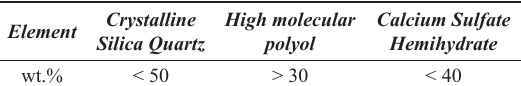
Mold Temperature (ºC) Ø = 1.0 section